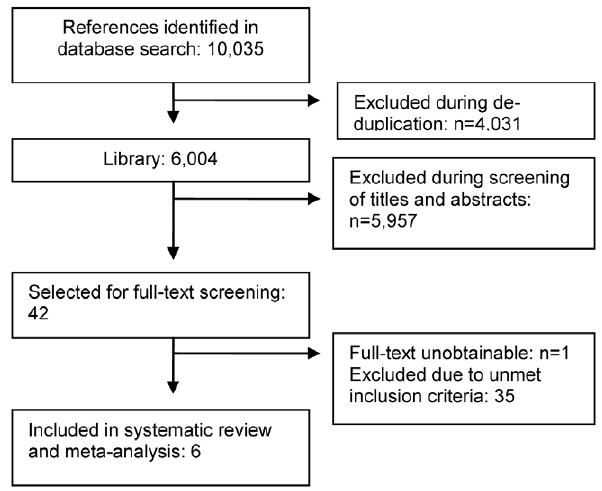
Figure 1. Study flow through the selection process. doi:10.1371/journal.pone.0052033.g001 PLOS ONE |